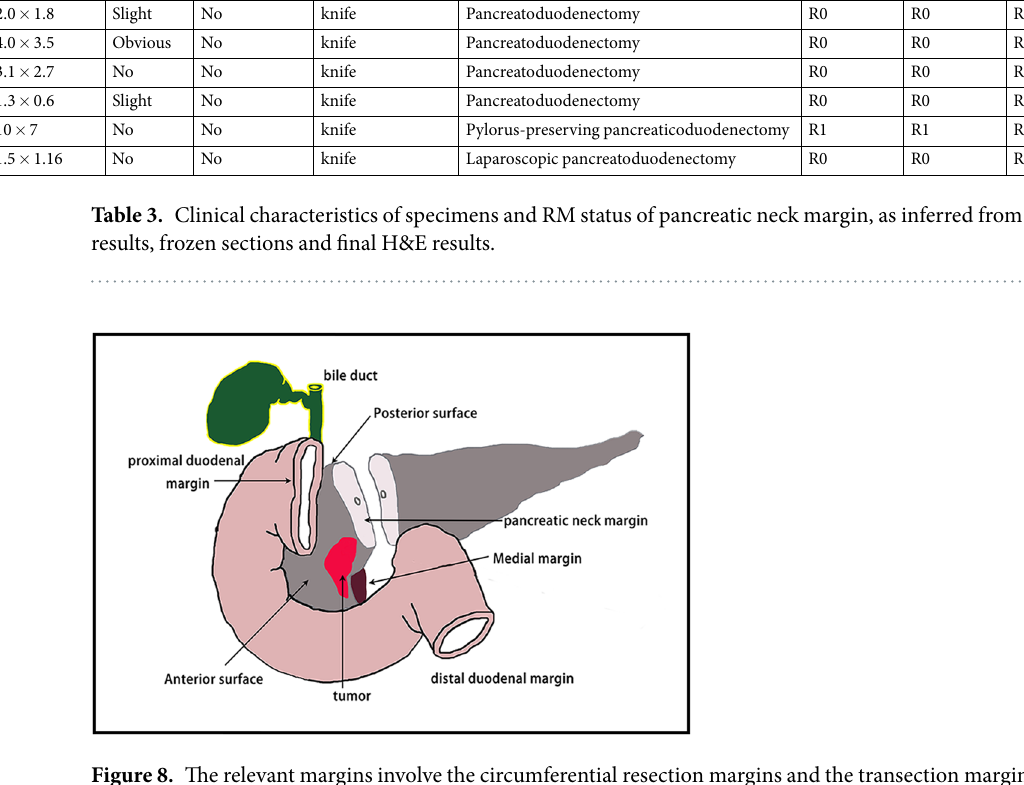
Figure 8. The relevant margins involve the circumferential resection margins and the transection margins of ductal adenocarcinoma in the pancreatic head. The circumferential resection margins include the posterior pancreatic surface, the medial margin and the anterior surface. The transection margins comprise the bile duct margin, the proximal duodenal margin, the distal duodenal margin, and the pancreatic neck